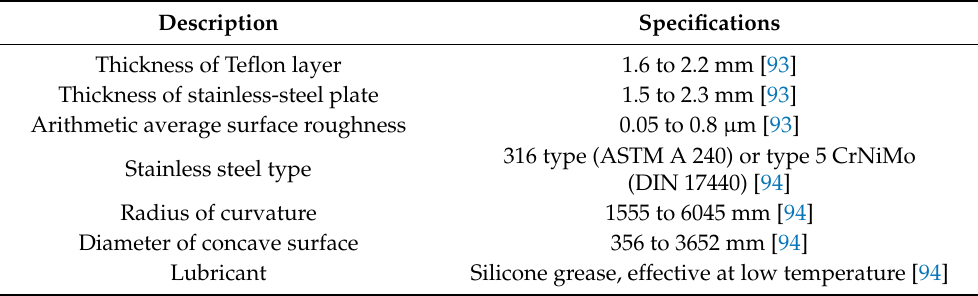
Table 1. Typical specification for FPS